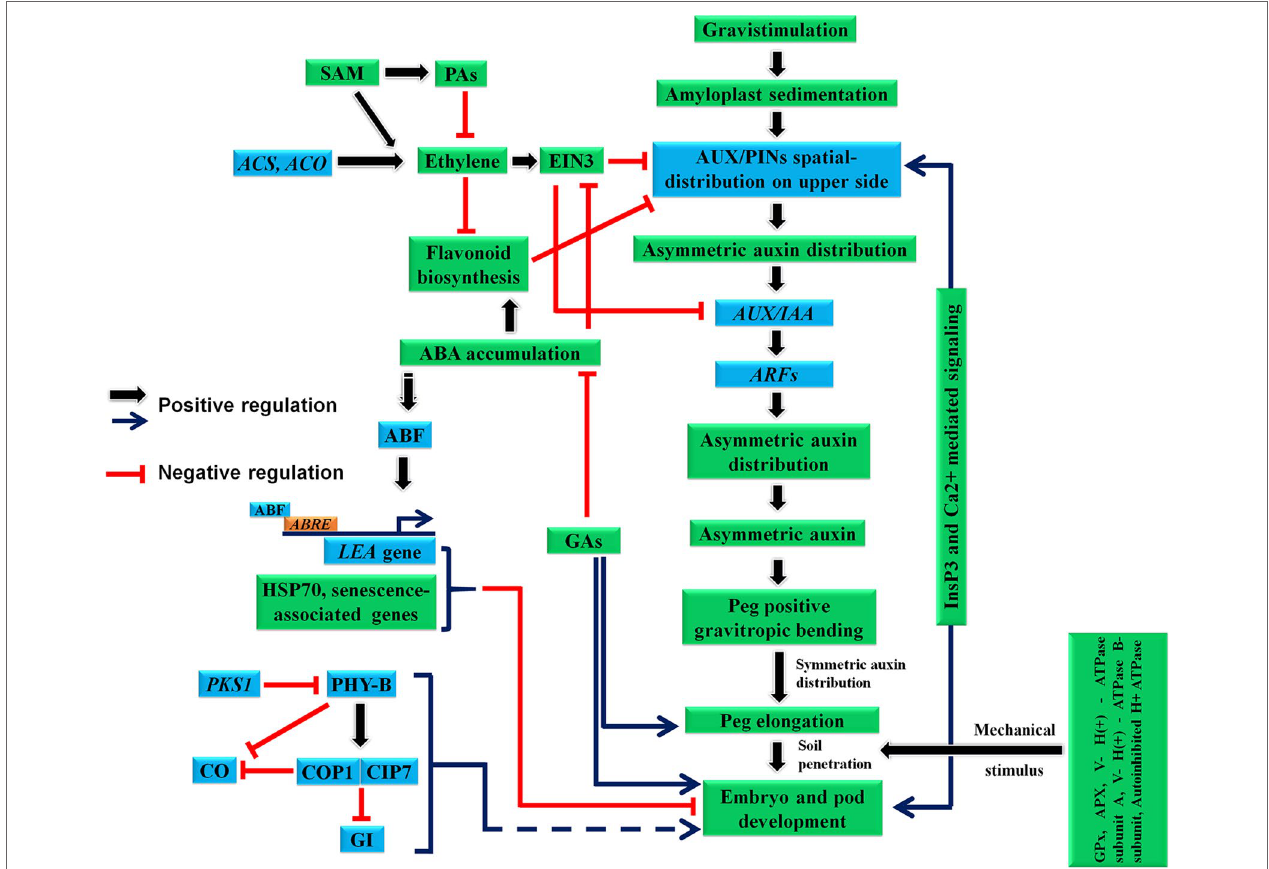
FIGURE 3 | Probable molecular regulatory mechanism involved during peg development, gravitropic bending, elongation and pod development. ABA, abscisic acid; ABRE, ABA-responsive element; ABF, ABRE-binding factors; ACO, ACC oxidase; ACS, ACC synthase; APX, Cytosolic ascorbate peroxidase; COP1, E3 ubiquitin– protein ligase constitutive photomorphogenic 1; CIP7, COP1-interacting protein 7; CO, constans; EIN3, ethylene-insensitive3; GA, Gibberellic acid; GI, gigantea; GPx, glutathione peroxidase; IM,; LEA, late embryogenesis abundant; PAs, polyamines; PHY-B, phytochrome; PKS1, phytochrome kinase substrate 1; SAM, S-adenosylmethionine; V- H(+) - ATPase subunit A, Vacuolar - H(+) - ATPase subunit A; V- H(+) - ATPase B-subunit, Vacuolar - H(+) - ATPase